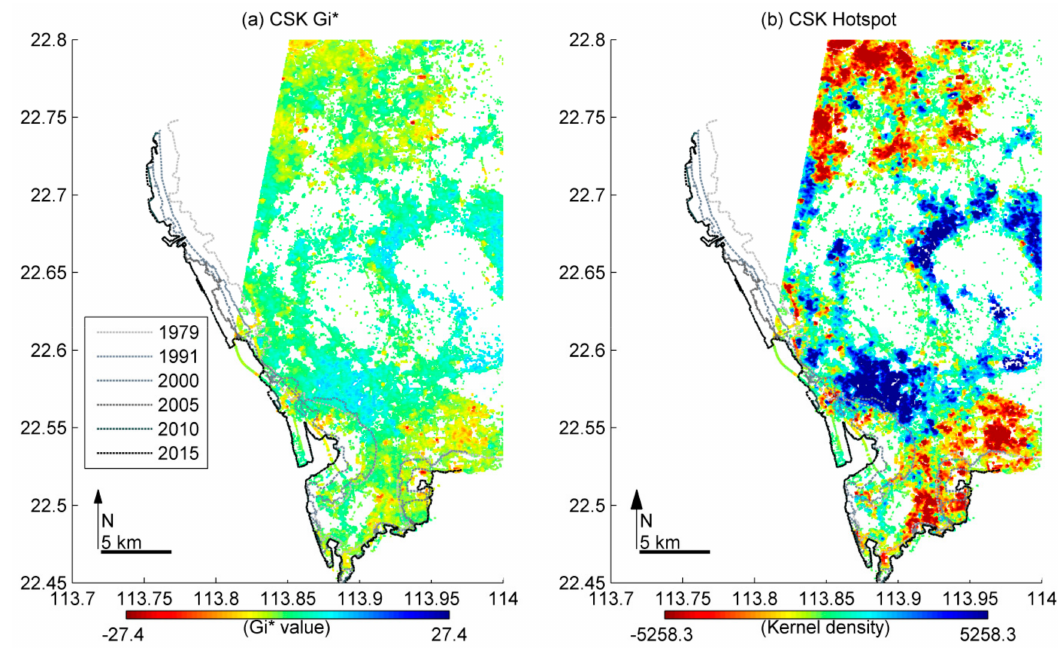
Figure A3. The clustering of mean rates using Getis–Ord Gi* statistic for CSK. ( a ) Gi* values; ( b ) Hotspot map derived from a kernel density estimation.